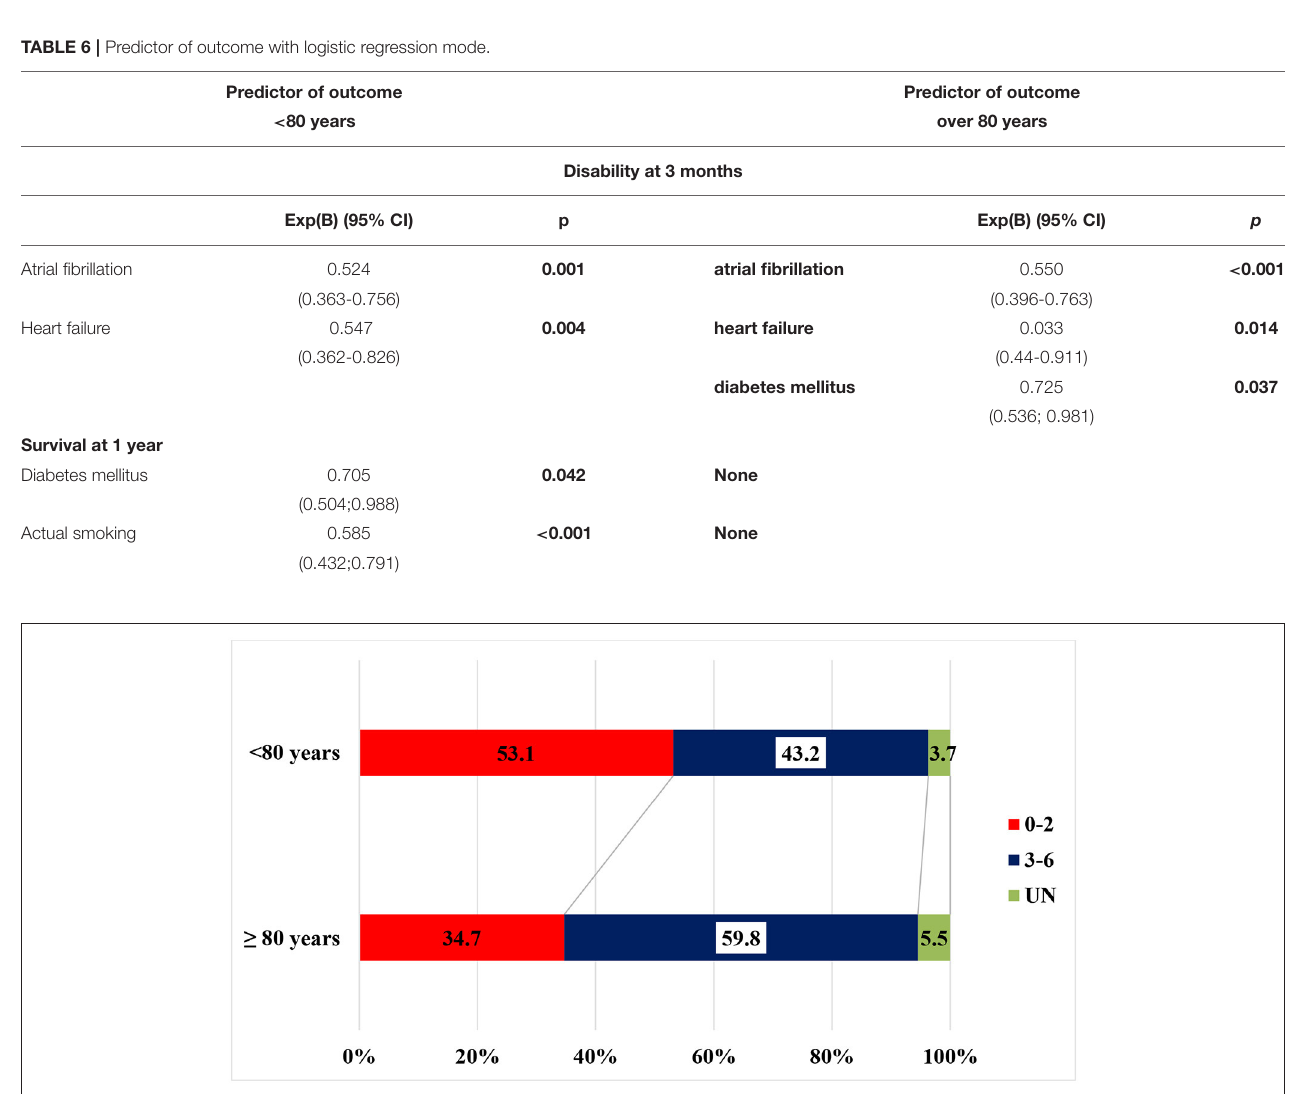
TABLE 6 | Predictor of outcome with logistic regression mode.